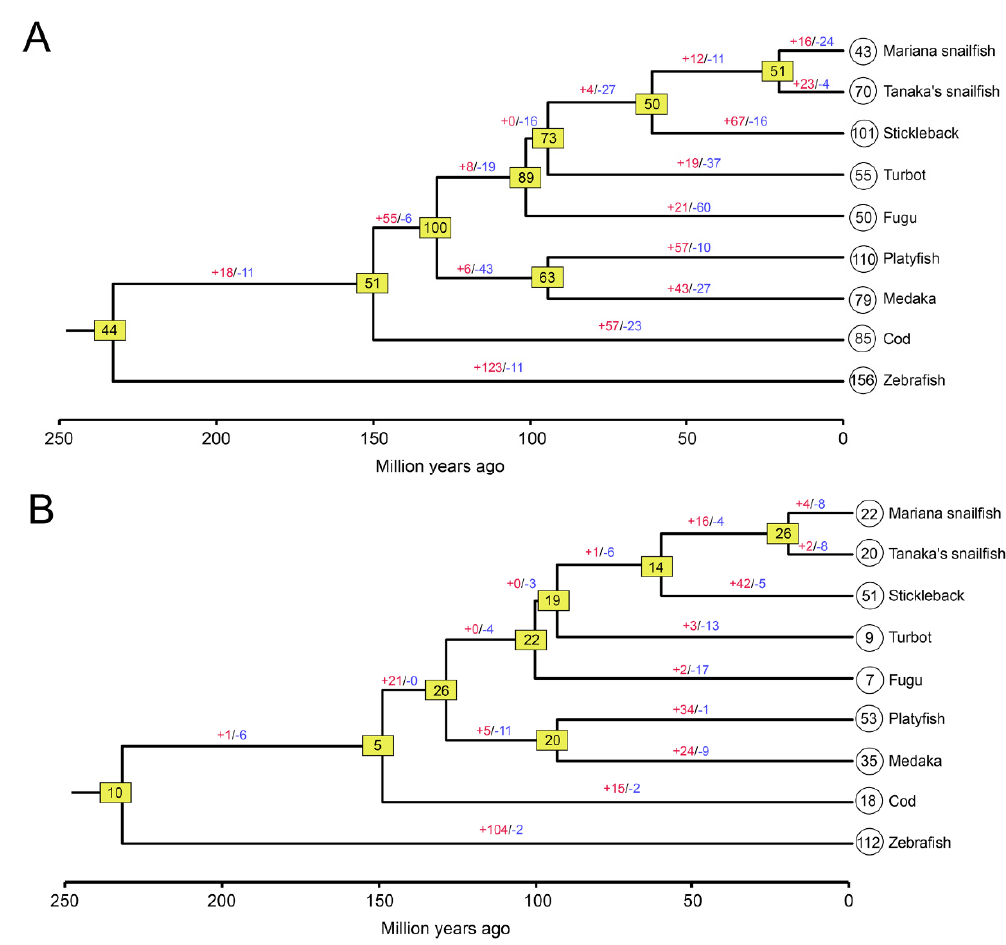
Figure 5. Estimation of gene gain and loss events and number of ORs ( A ) and TAARs ( B ) in the ancestral species. Number of gene gains and losses are shown on each branches with + and − , respectively. Numbers in yellow boxes indicate the number of ancestral nodes, and the numbers of intact genes in extant fish species are shown in circles. The approximate divergence times of the nine fish species was inferred from references.